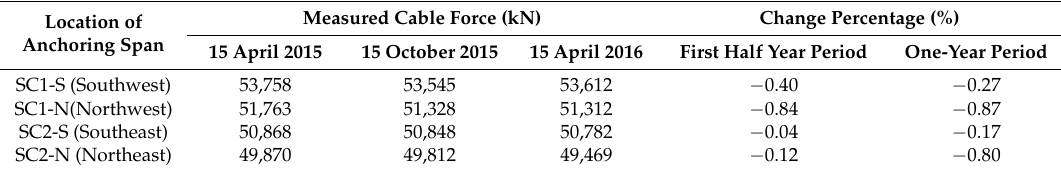
Table 4. Measured cable force and change percentage.